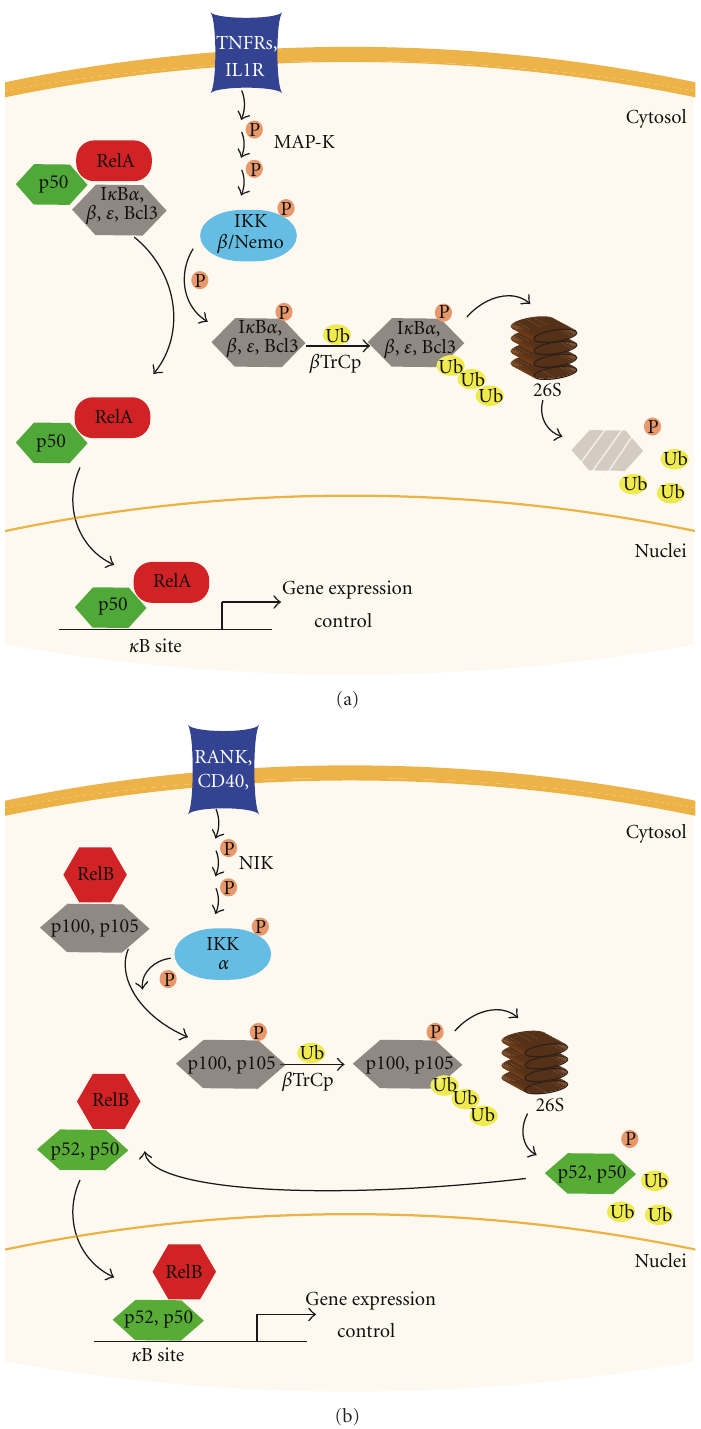
Figure 1: Canonical and non-canonical NF- κ B signalling pathways. (a) The classical NF- κ B pathway activation follows a trans- phosphorylation chain from the specific activated receptors to the I κ B proteins. This triggers NF- κ B heterodimer to entry into the nucleus and control the gene expression by binding to κ B sites within promoter regions. (b) In the non-canonical signaling, trans-phosphorylation and proteasome degradation are needed before active NF- κ B can access into the nucleus. TNFR: TNF α receptor; IL1R: IL-1 β